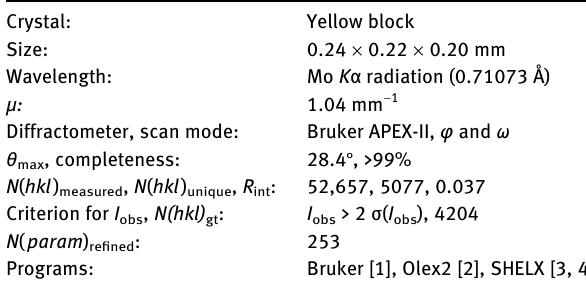
Table  : Data collection and handling. Crystal: Yellow